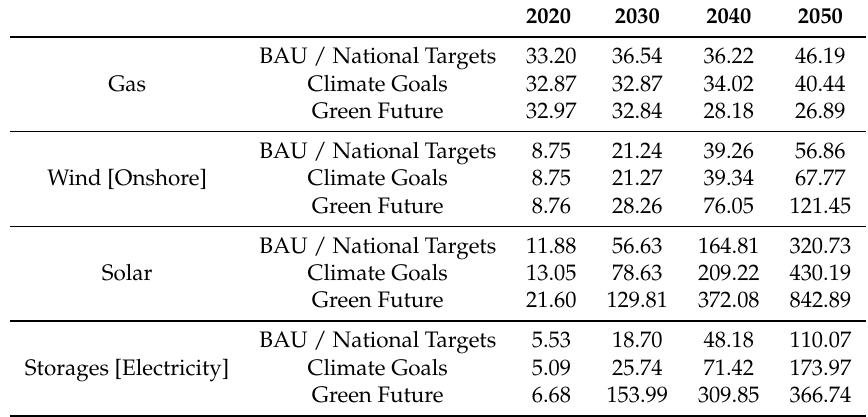
Table 2. Installed capacities for major electricity-generating and storage technologies across scenarios in GW.